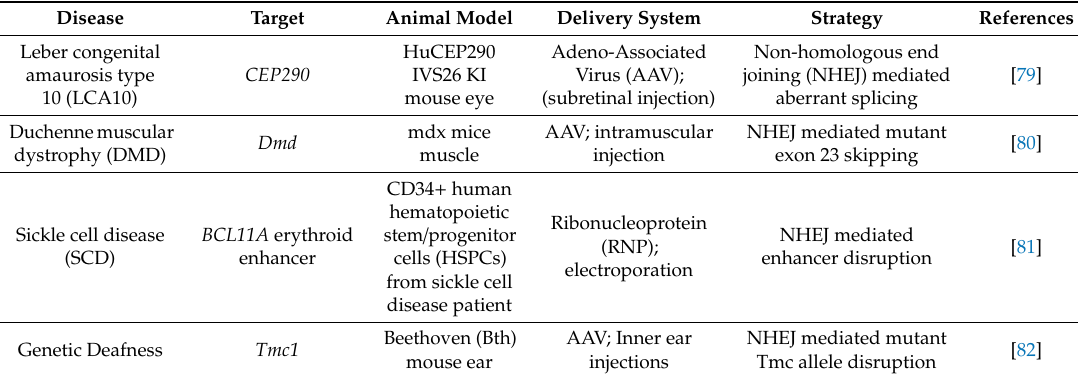
Table 3. CRISPR–Cas applications in selected monogenic